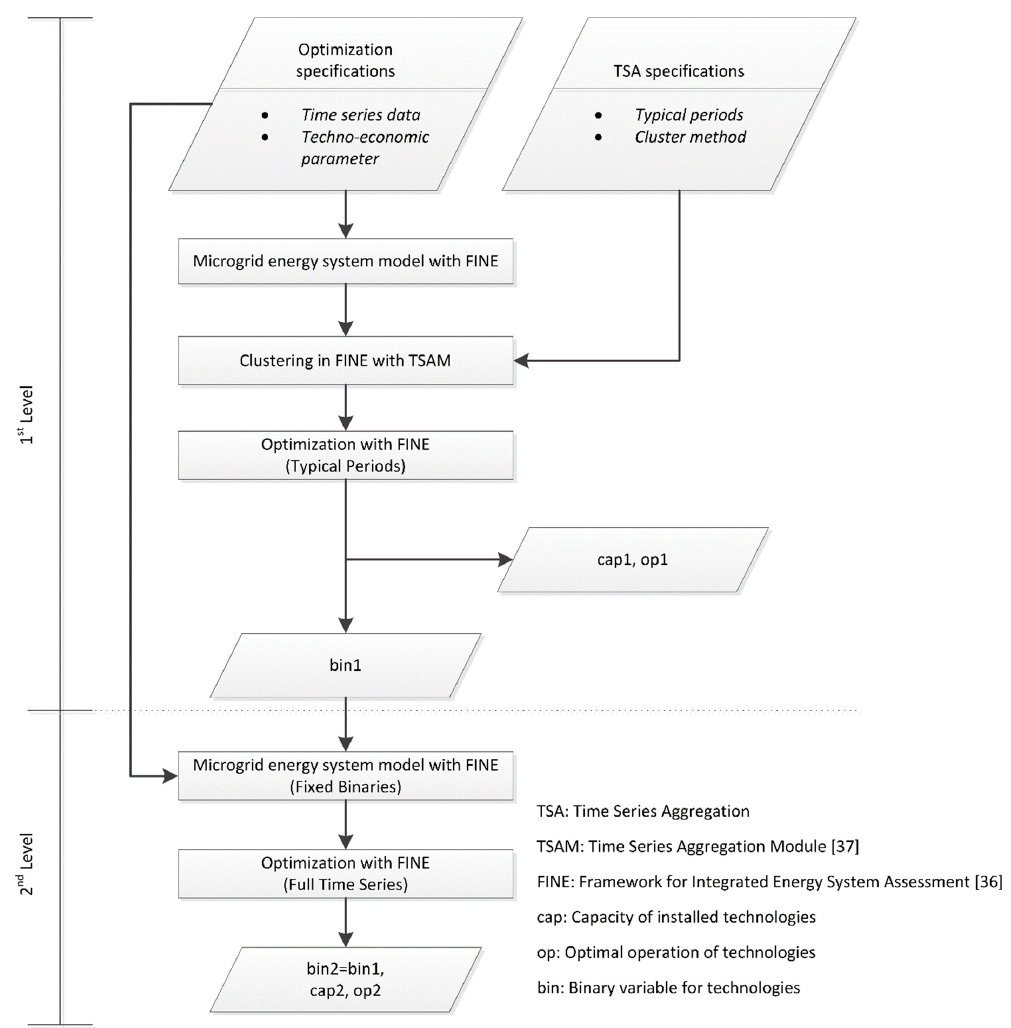
Figure 1. Workflow of 2-Level